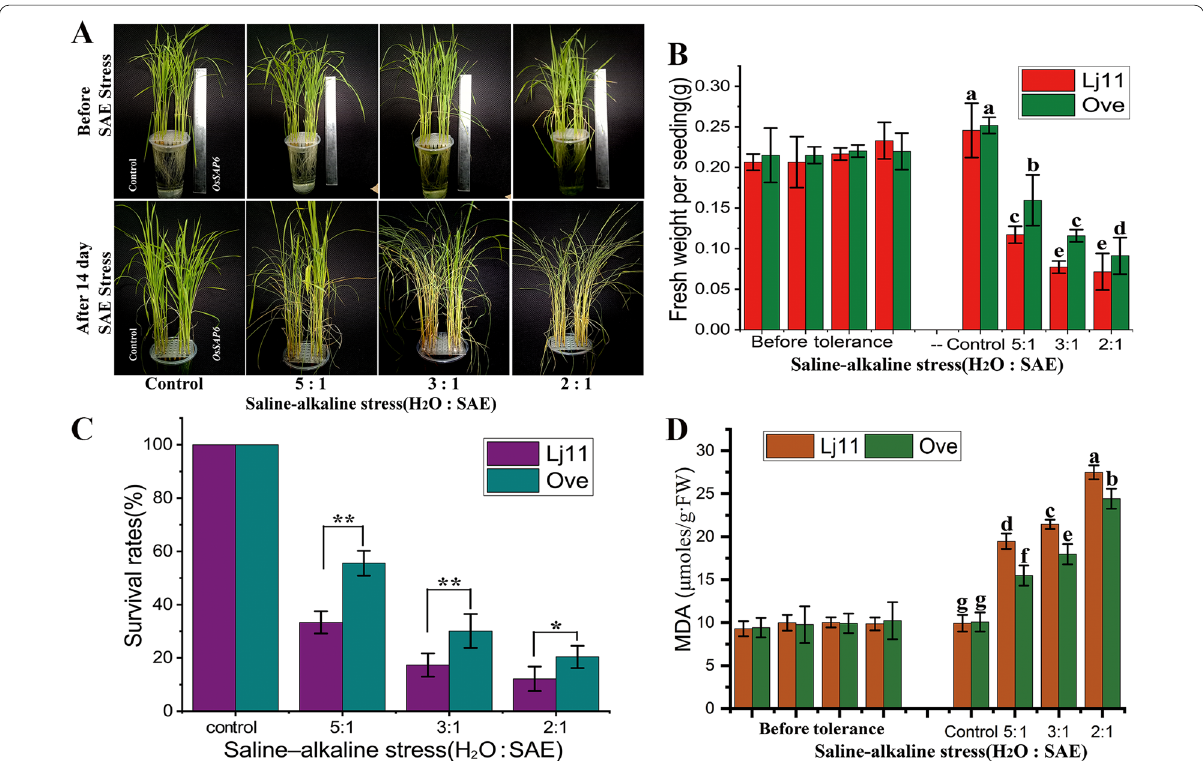
Fig. 4 Overexpression of OsSAP6 in rice enhances tolerance to soda saline–alkaline stress during growth period. Four-week-old Lj11 (three rows on the left) and OsSAP6 overexpression line T3-#10 (three rows on the right) seedlings were treated with different concentrations of SAE